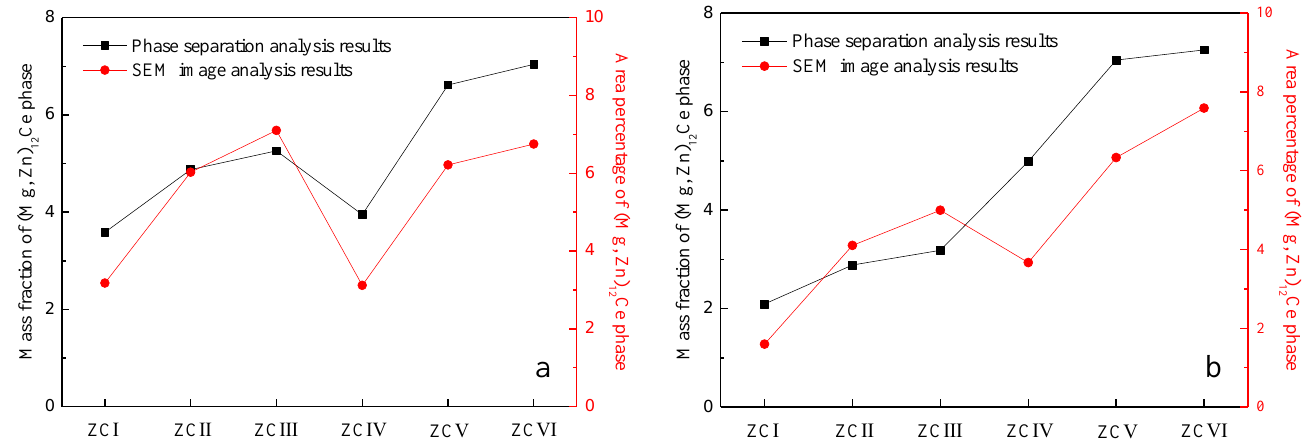
Figure 8. Comparison of quantitative analysis results of the (Mg, Zn) 12 Ce phase. ( a ) As-cast alloys, ( b ) homogeneous alloys.